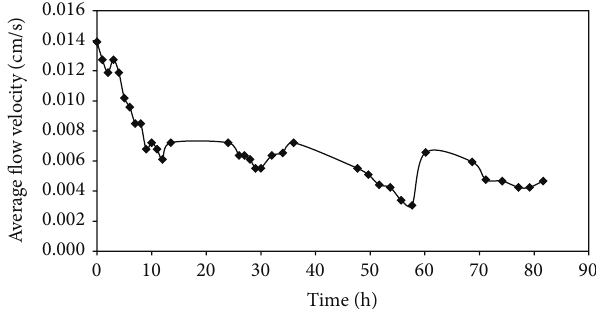
Figure 8: Relationship between the average flow velocity in the tailings column and time under the hydraulic gradient of 0.625 (experiment 2).